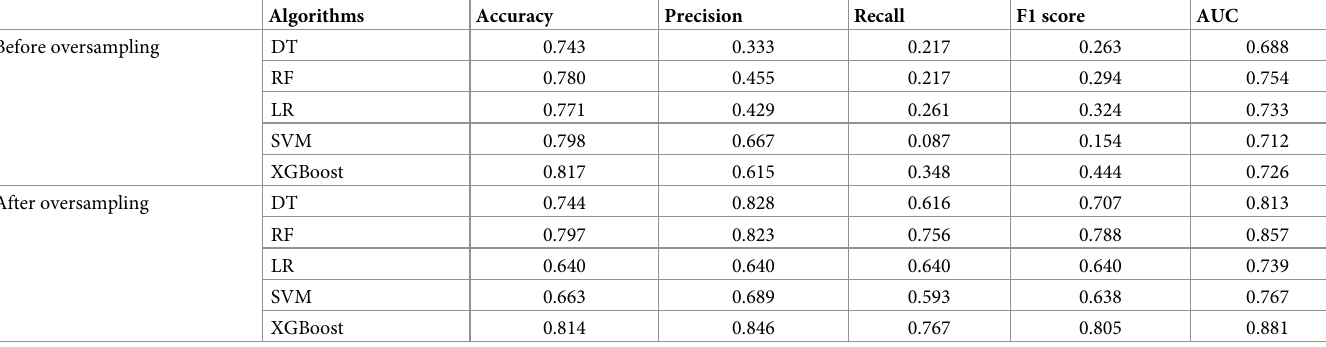
Table 4. Performance parameter values for five machine learning algorithms before and after over-sampling.